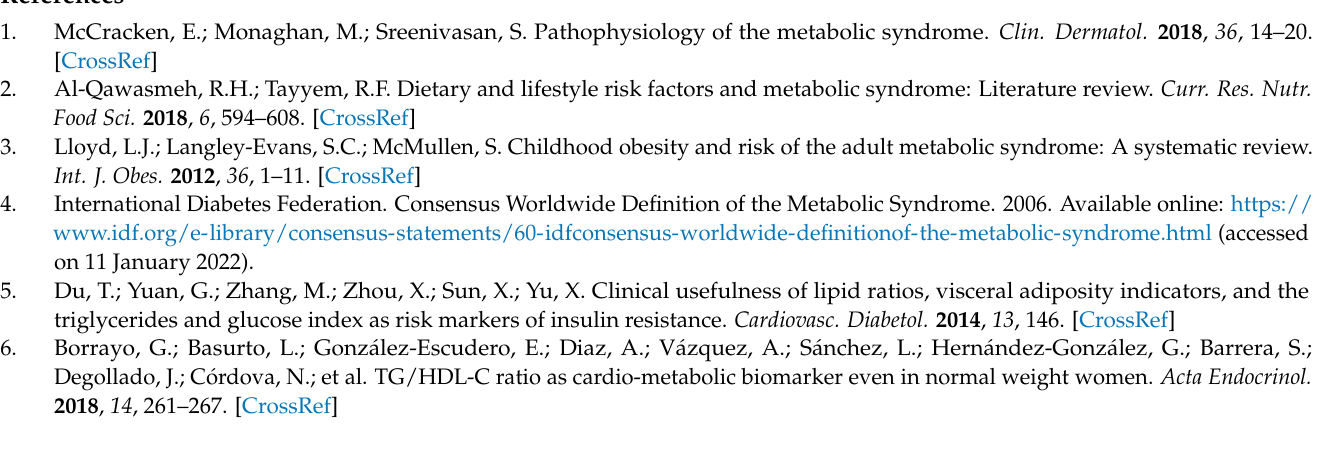
Figure S2: Comparation of TG/HDL-c ratio with Low-density lipoprotein to high density lipoprotein (LDL-c/HDL-c), Total Cholesterol to high-density lipoprotein (TC/HDL-c) and Homeostasis Model Assessment-Insulin Resistance (HOMA-IR). Table S1: Comparison of metabolic data between groups with and without MS; Table S2: Association of TG/HDL-c ratio with the phase of life at obesity onset and Metabolic